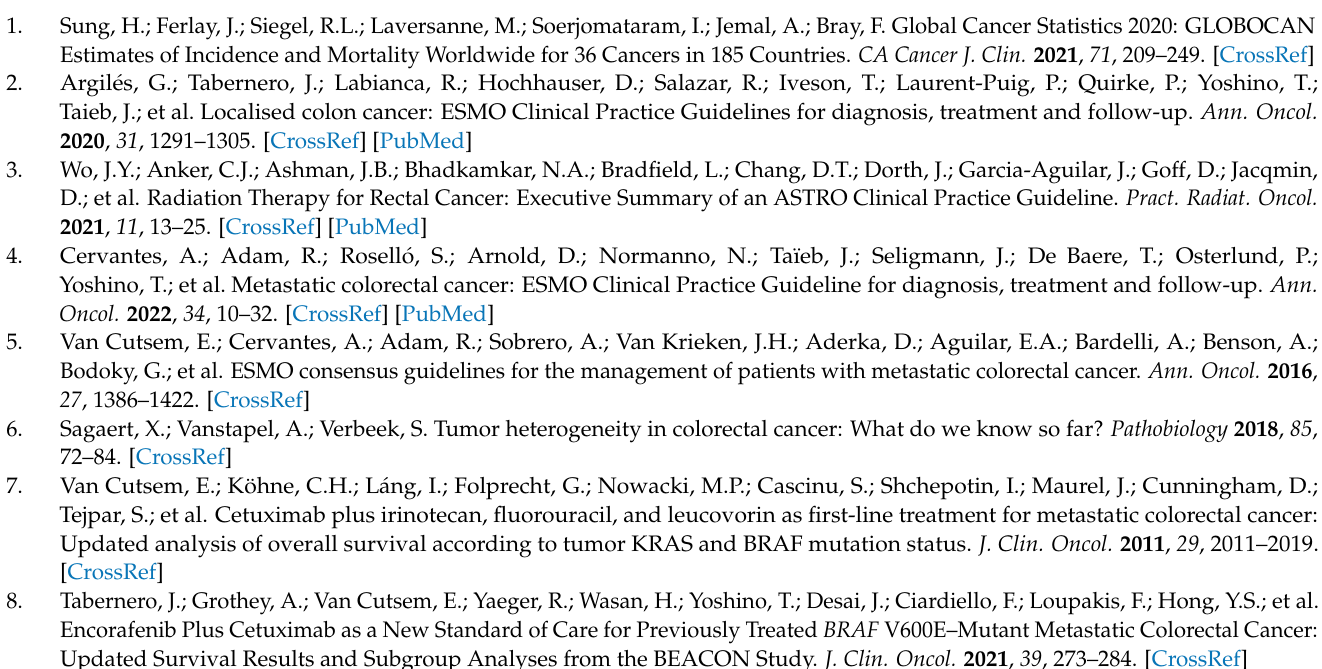
Table S2: Summary of organoid drug sensitivity and radiosensitivity testing methods used in studies of ex vivo drug sensitivity and patient treatment